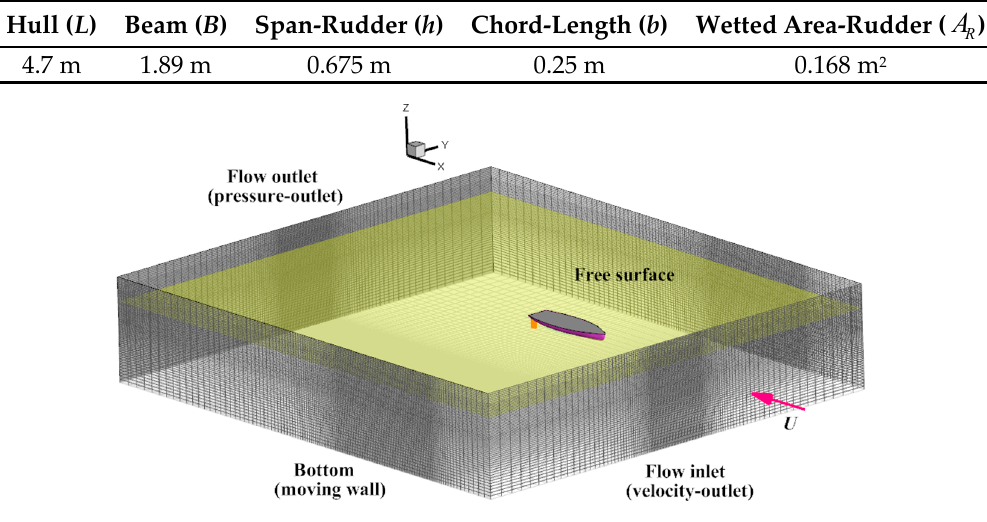
Table 1. Parameters of 470 Sailing yacht [11].